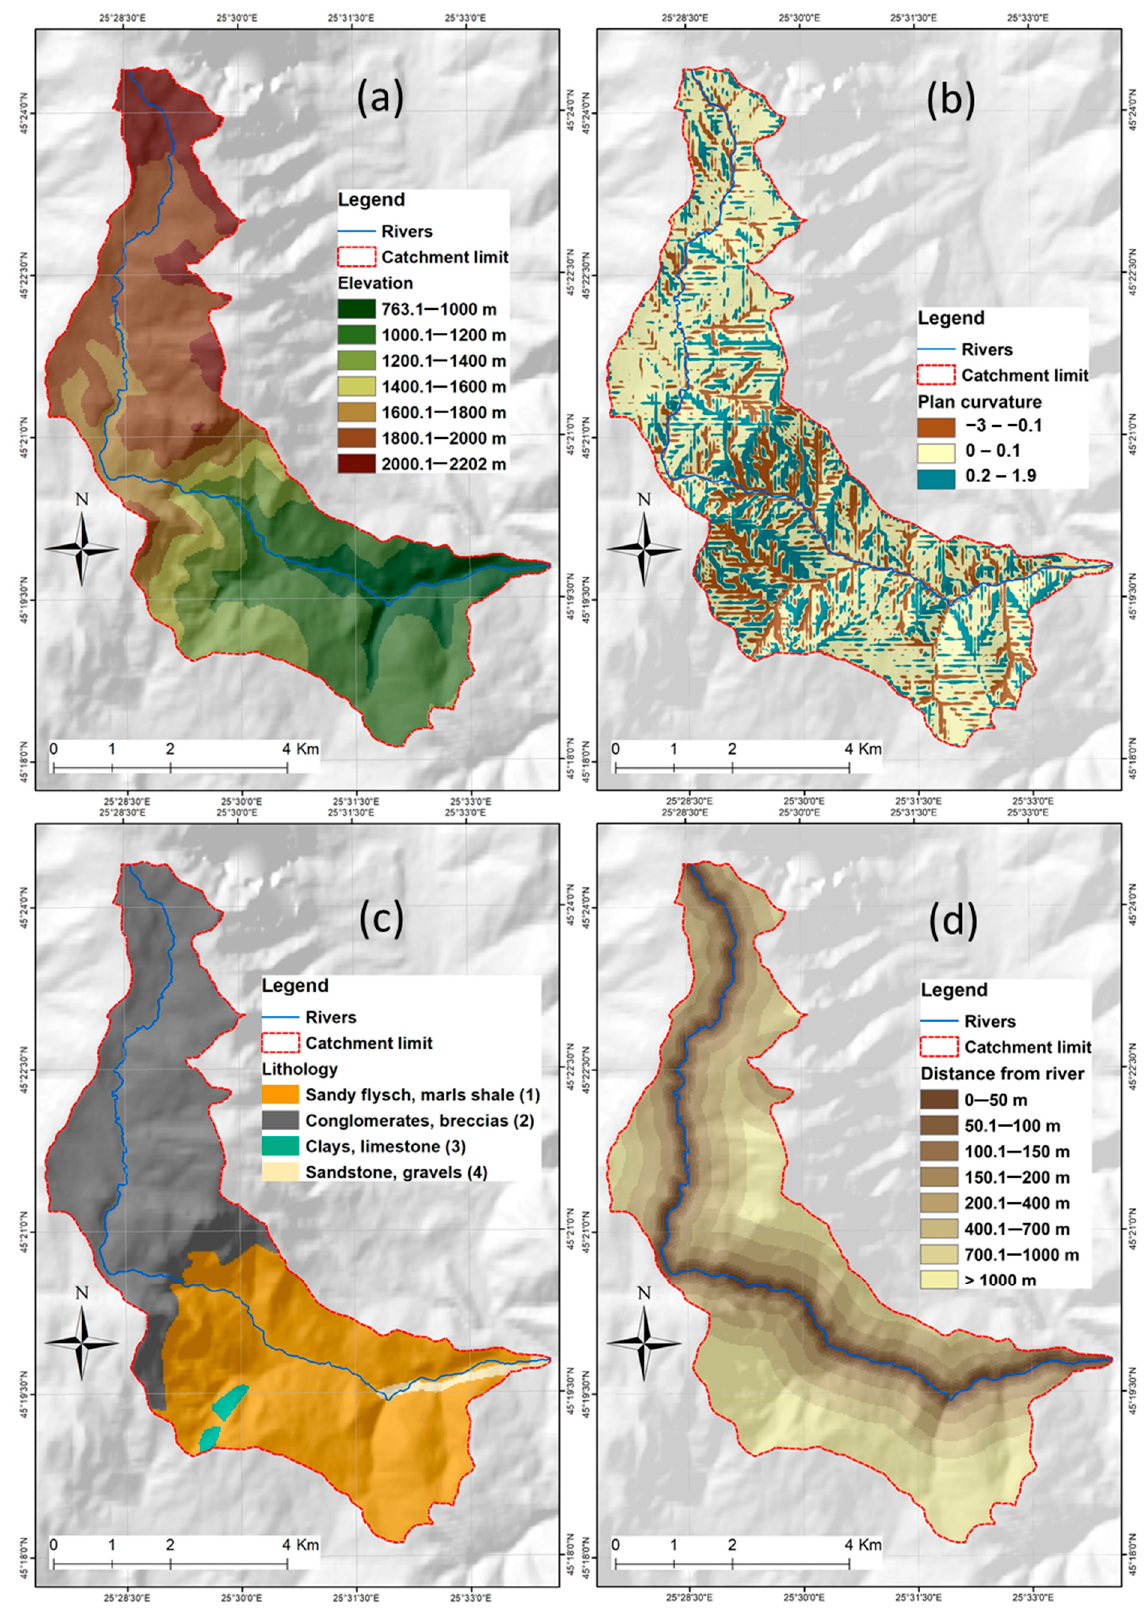
Figure 4. Flash-flood and flood predictors. ( a ). Elevation; ( b ) Plan curvature; ( c ) Lithology; ( d ) Distance from rive.